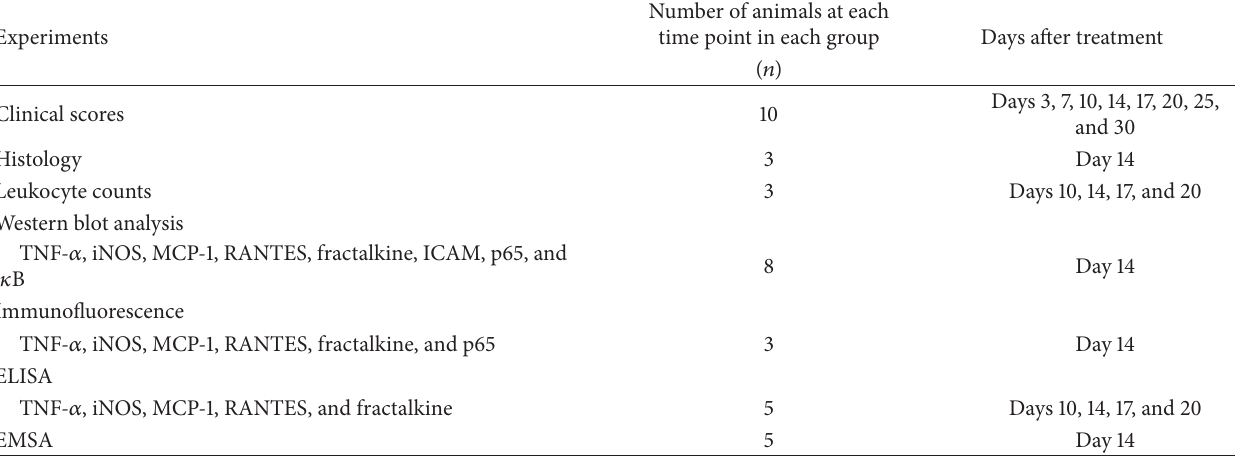
Number of animals at each time point in each group Days after treatment ( 𝑛 )